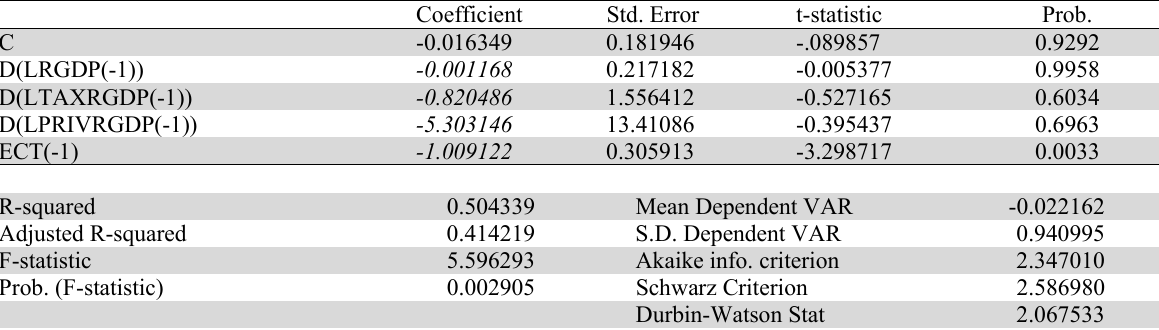
Error correction regression